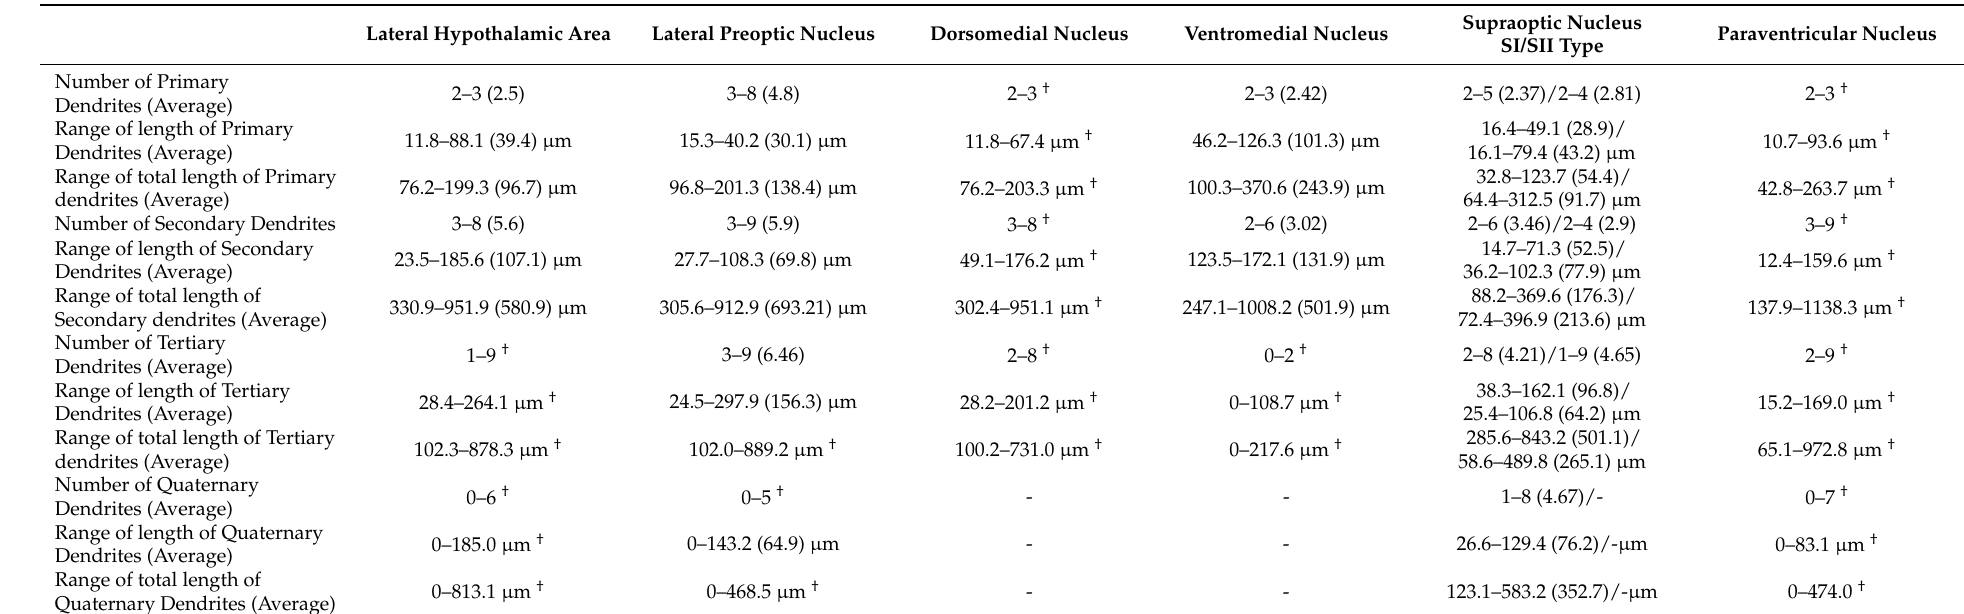
Table 2. Morphometric analysis of the neurons of the nuclei of the